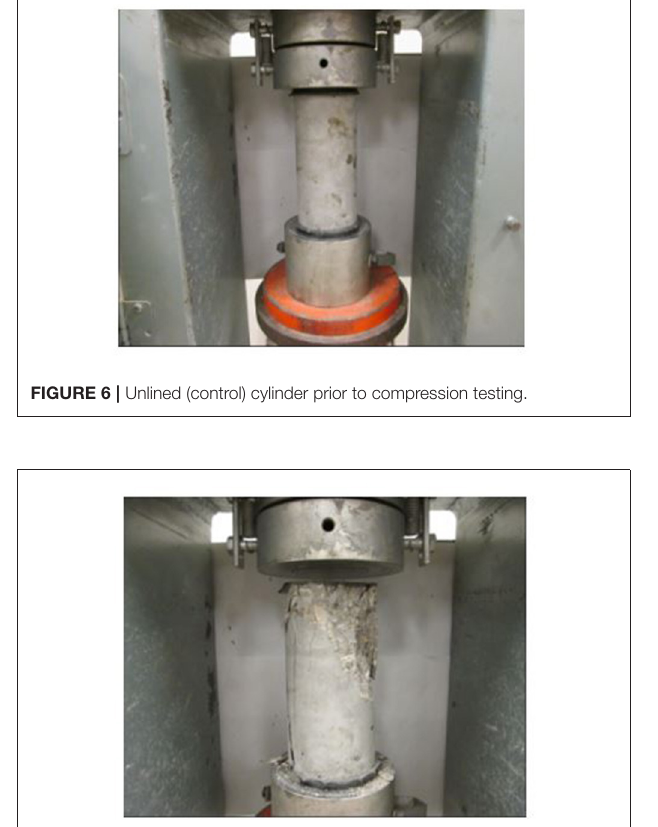
FIGURE 7 | Unlined (control) cylinder after compression testing.